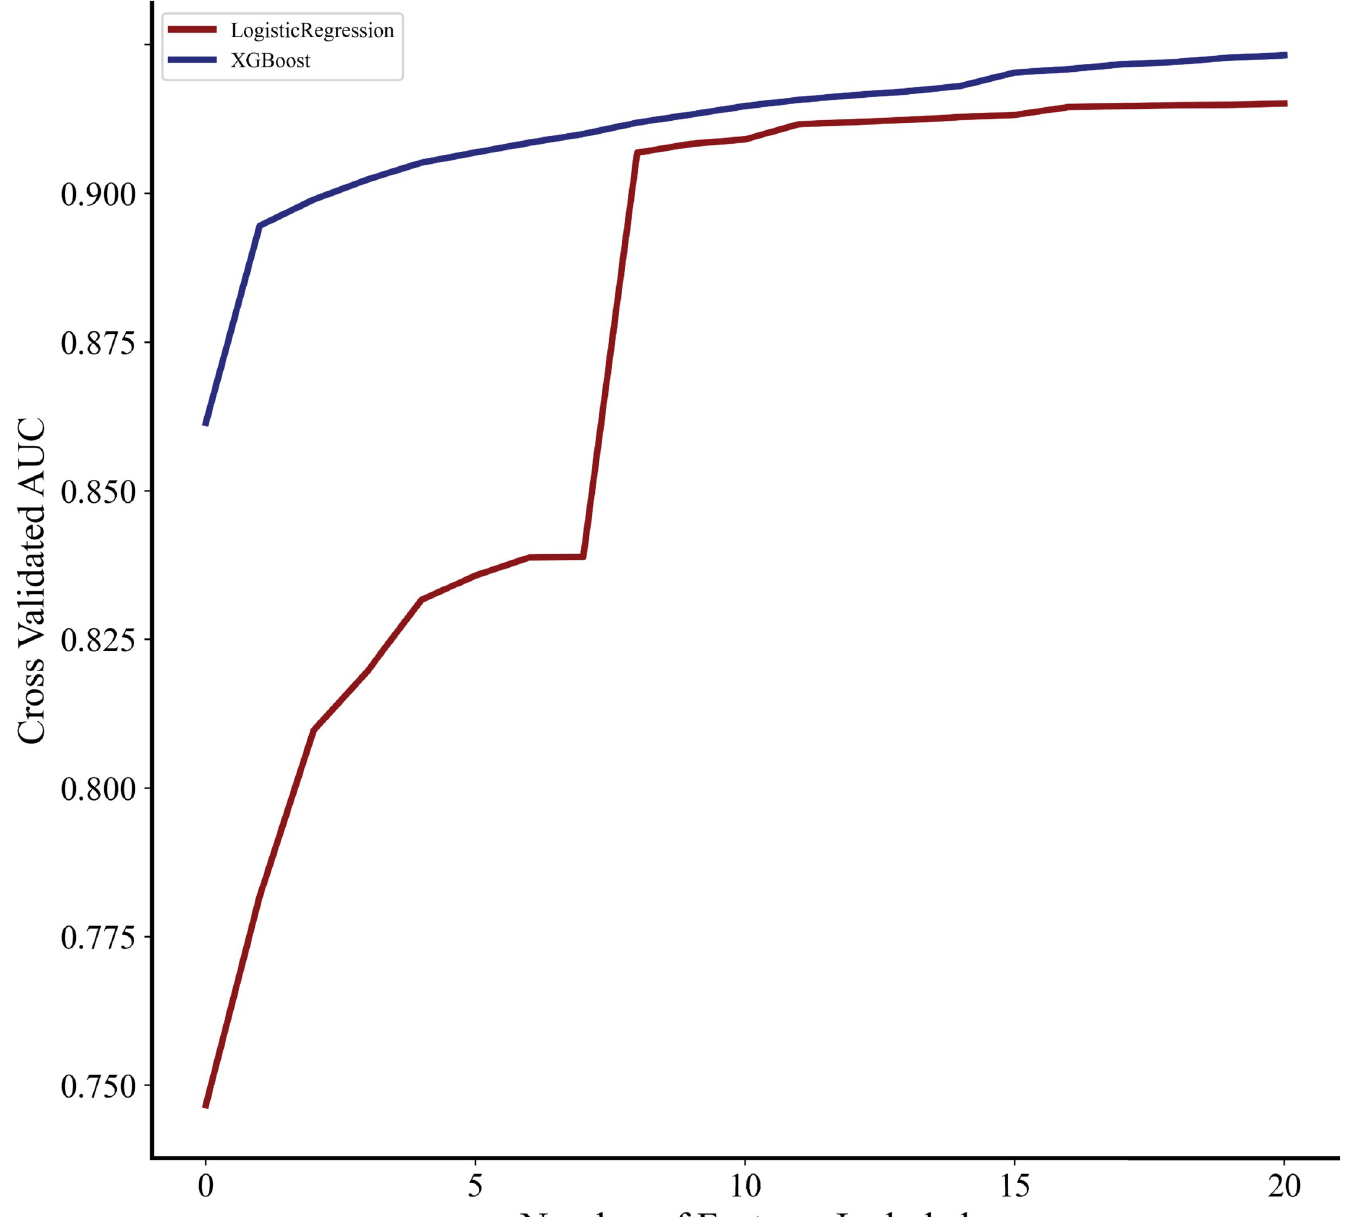
Fig 1. Relationship between covariates and AUC. Impact of number of model covariates on area under the receiver operating characteristic